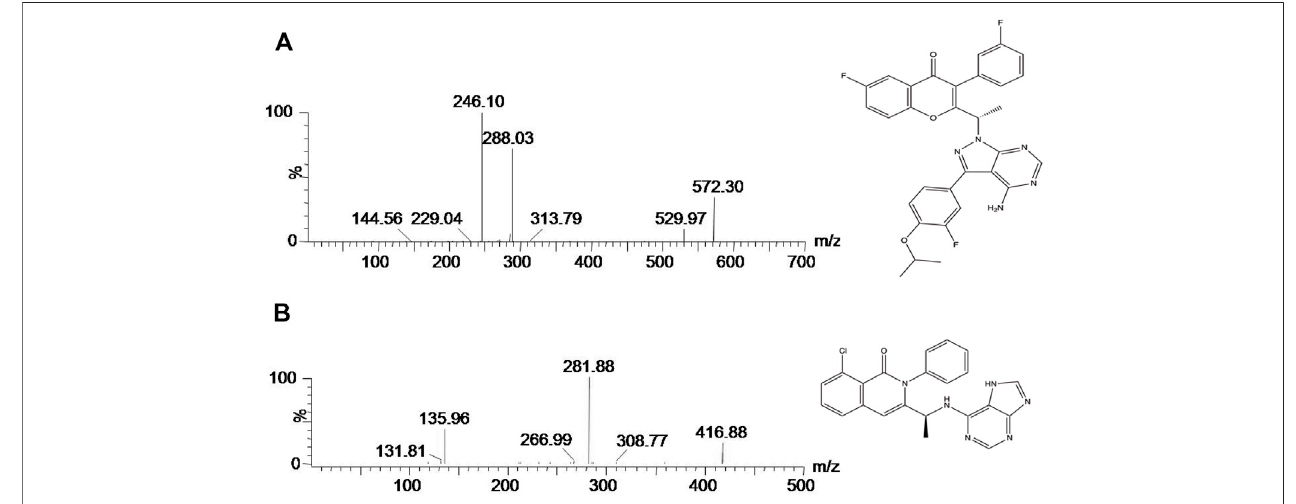
FIGURE 1 | Mass spectra of umbralisib (A) and duvesilib [IS, (B) ] in this study.